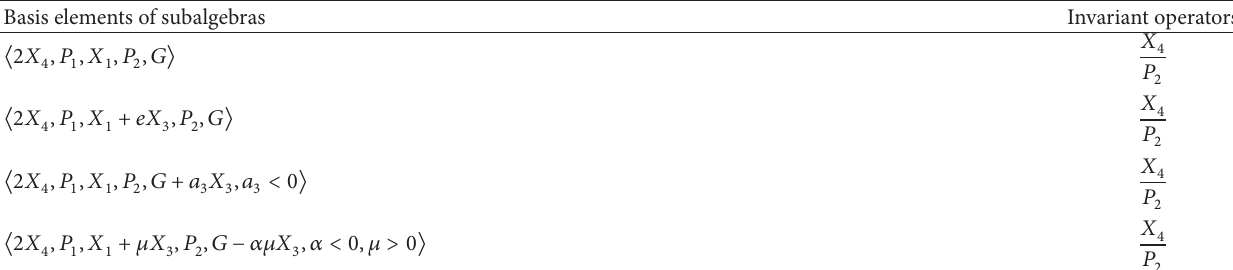
Table 25: Invariant operators of subalgebras of the type 𝐴 𝑎𝑏 5,19 (𝑎 = 1, 𝑏 = 1) . Basis elements of subalgebras